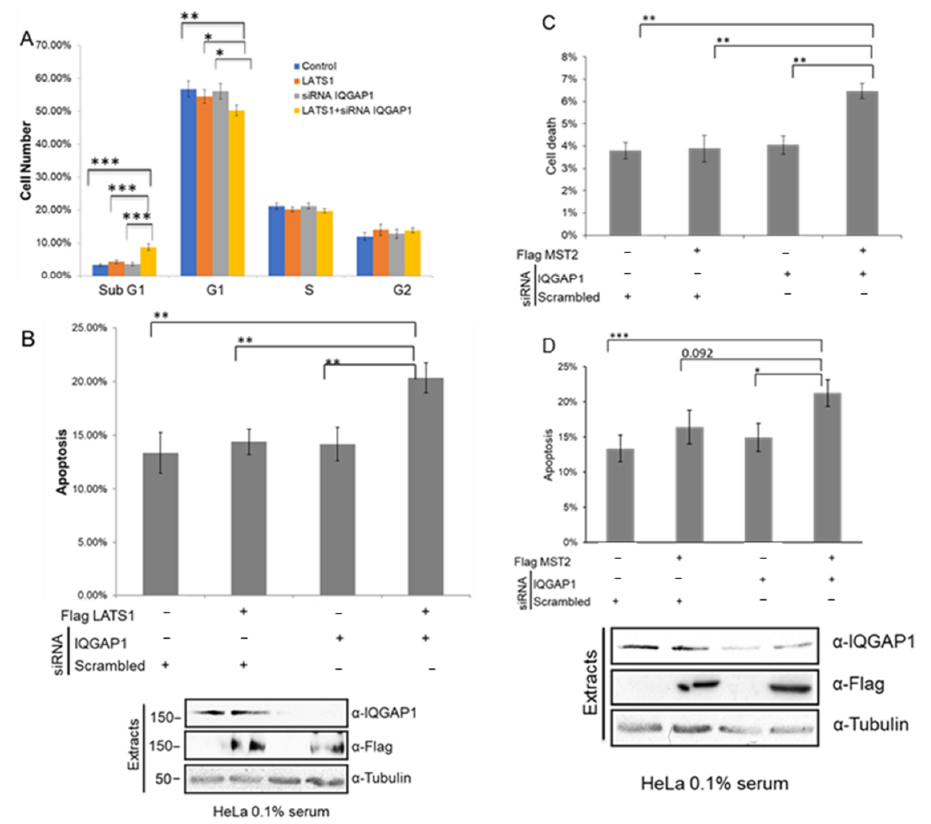
Figure 5. IQGAP1 regulates LATS1- and MST2-dependent apoptosis. ( A ) HeLa cells co-transfected with IQGAP1 or non-targeting siRNA pool and Flag-LATS1 and serum deprived for 16 h. Cell cycle distribution was assessed by PI staining using flow cytometry. ( B ) Upper panel: Caspase 3/7 activation of HeLa cells transfected as in A measured by FITC-VAD-FMK binding after starvation. Lower panel: Total lysates corresponding to the apoptotic assay analysed by western blot. ( C ) HeLa cells co-transfected with IQGAP1 or non-targeting siRNA pool and Flag-MST2 and starved for 16 h. Cell death was assessed by PI staining using flow cytometry and measuring subG1 population. ( D ) Upper panel: Caspase activity of HeLa cells transfected as in C measured by FITC-VAD-FMK binding after starvation. Lower panel: Total lysates corresponding to the apoptotic assay analysed by western blot. p -values were obtained by Student’s t -test, n = 3, error bars indicate SEM, * = p < 0.05, ** = p < 0.01, *** = p <